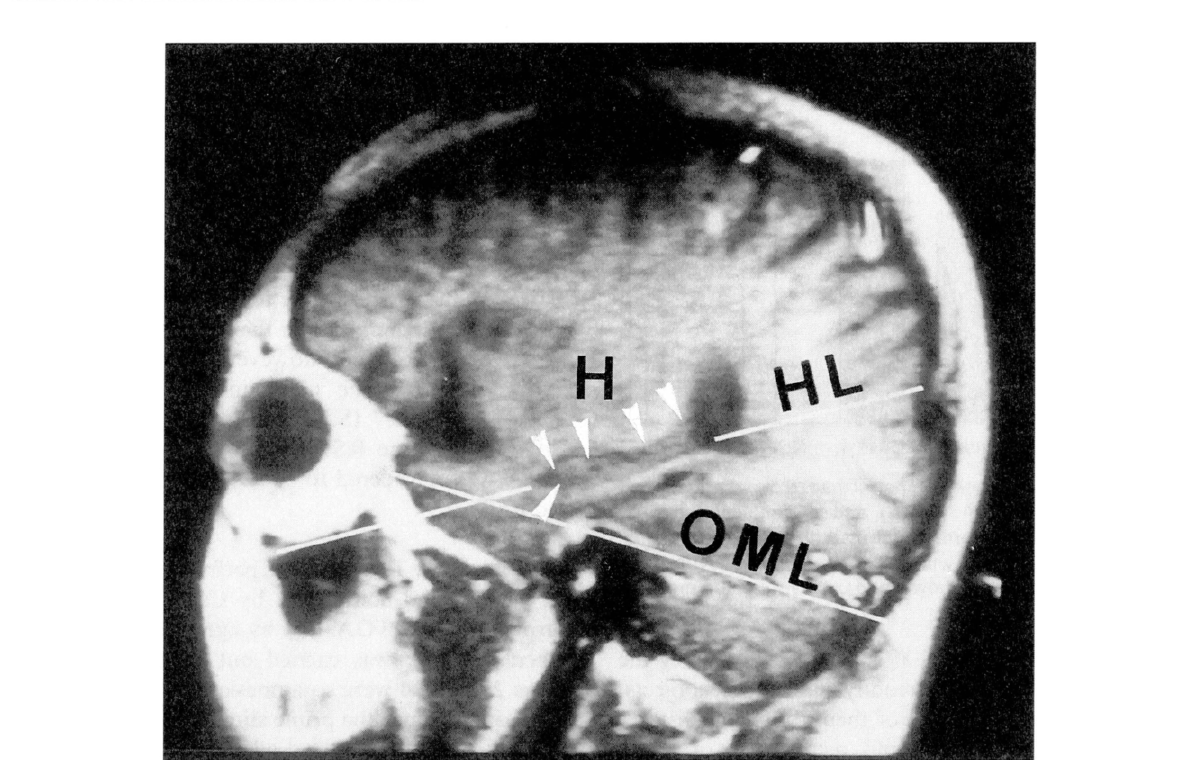
TABLE Ii. Results of memory tests Case 1 Case